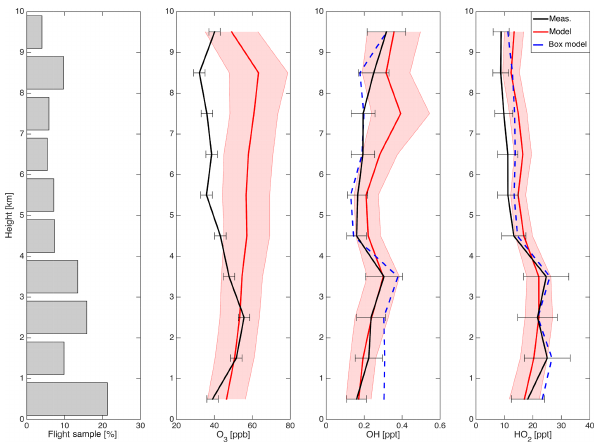
Figure 3. Vertical profiles of median modeled (red) and measured (black) ozone, OH, and HO 2 for Houston-based INTEX-B flight data binned by kilometer. Gray bar graph shows percent of flight data within each vertical bin. Shaded regions represent 1 σ of the model ensemble; error bars on measurements are uncertainty at 1 σ confidence. Blue line represents results from the box